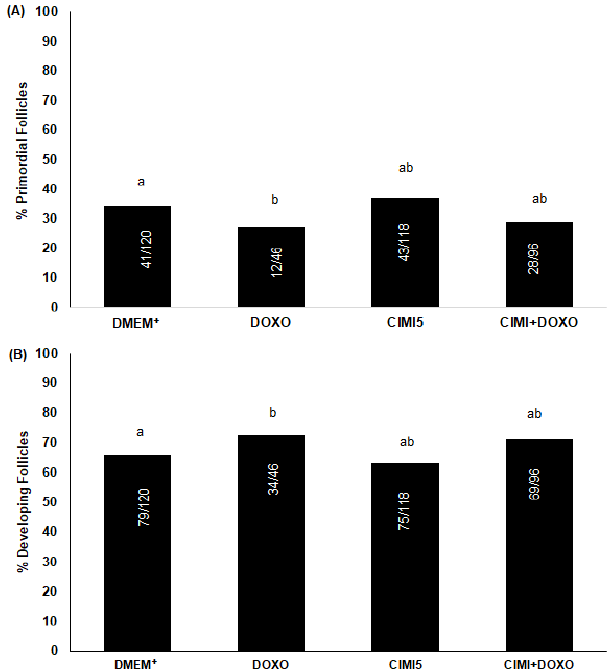
Figure 6. The percentage (mean ± SE) of primordial ( A ) and developing ( B ) follicles in ovaries cultured in DMEM + alone or supplemented with DOXO (0.3 µ g/mL), CIMI (5 ng/mL) and both CIMI and DOXO (5 ng/mL + 0.3 µ g/mL). The percentage of primordial and developing follicles was evaluated using the chi-square test. a and b different lowercase letters indicate statistically significant differences between treatments ( p < 0.05). Numbers of follicles evaluated are shown within each column.